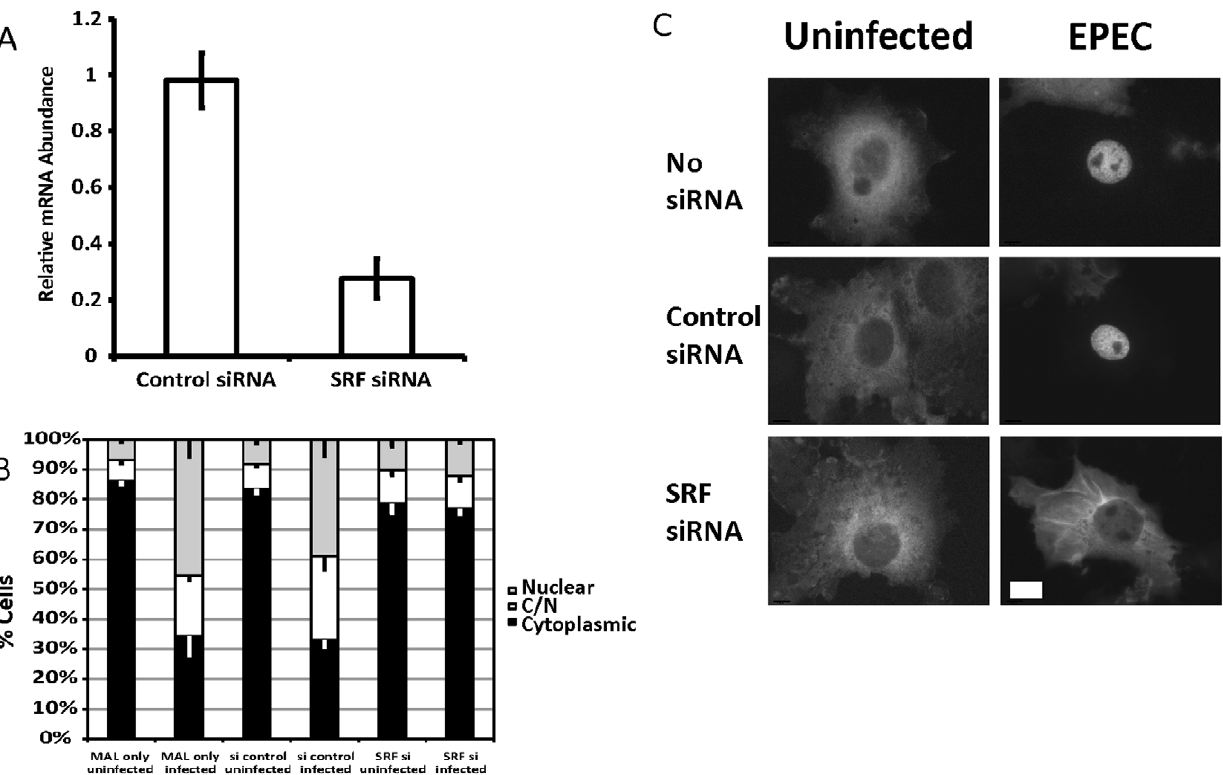
Figure 2. SRF is important for EPEC induced MAL-GFP translocation. A. COS-7 cells transfected with siRNA targeting SRF or a non-targeting siRNA. After 72 hours knockdown efficiency was assessed using real-time quantitative RT-PCR with SRF specific primers and normalized to GAPDH . Shown are means of three experiments 6 standard deviation. B. Infection of SRF-knockdown cells with EPEC results in a significant reduction in nuclear accumulation of MAL-GFP, P=0.0081 relative to the no siRNA control. Data are the means of at least 3 experiments where a minimum of 150 transfected cells were counted for each condition of each experiment. Values are means 6 SEM. C. Representative images of cells counted in panel B. Scale Bar=20 m